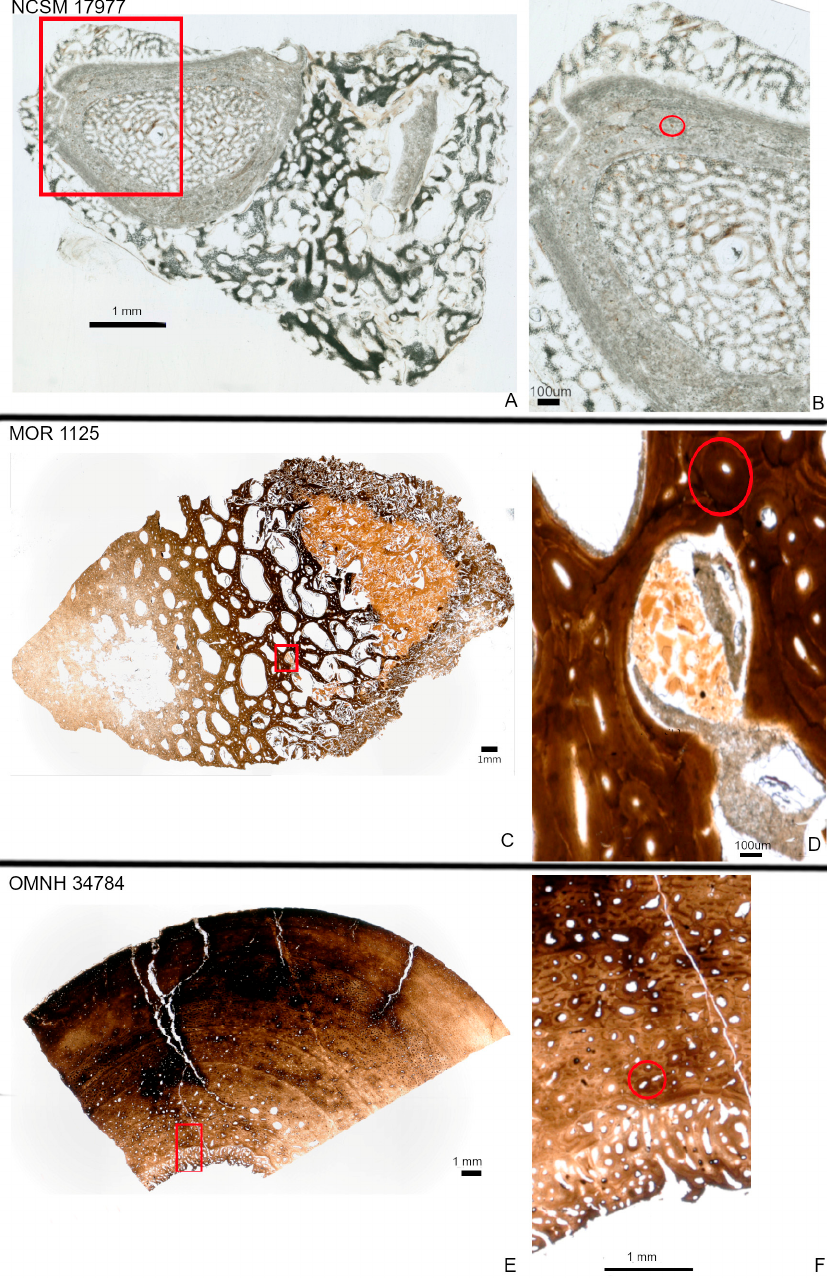
Figure 1. Histology of NCSM 17977 (radius; ( A , B )), MOR 1125 (femur fragment; ( C , D )) and OMNH 34784 (tibia fragment; E , F ). Red boxes indicate where areas of higher magnification were taken. Areas of higher magnification represent those areas scanned for synchrotron XRF. NCSM 17977 is represented by a completed transverse section ( A ). The normal radius wall is composed of cortical bone with large secondary osteons (highlighted with red circle; ( B )). Pathological tissues on both the periosteal and endosteal surfaces consist of trabeculae. The femur fragment of MOR 1125 consists of a dense Haversian tissues identified by multigenerational secondary osteons (highlighted with red circle) and trabeculae, with crushed bone between some trabeculae ( D ). OMNH 34784 consists of both a “normal” cortex and an unusual endosteal tissue deposited along the endosteal margin and filling part of the medullary cavity ( E ). The cortex is comprised of fibrolamellar bone that is more remodeled towards the endosteal margin as seen by multigenerational secondary osteons (highlighted with red circle; ( F )).